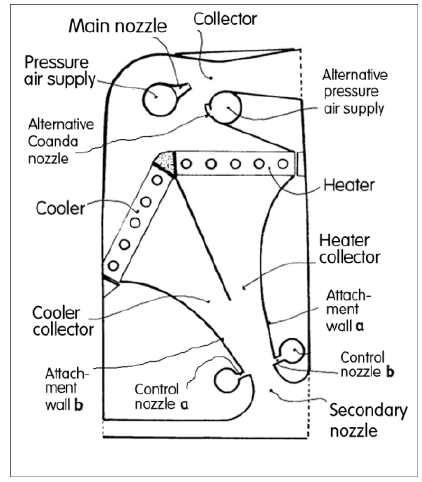
Alternative induction-type fluidic jet-attachment diverter [7] in the terminal unit of water/air window-sill terminal